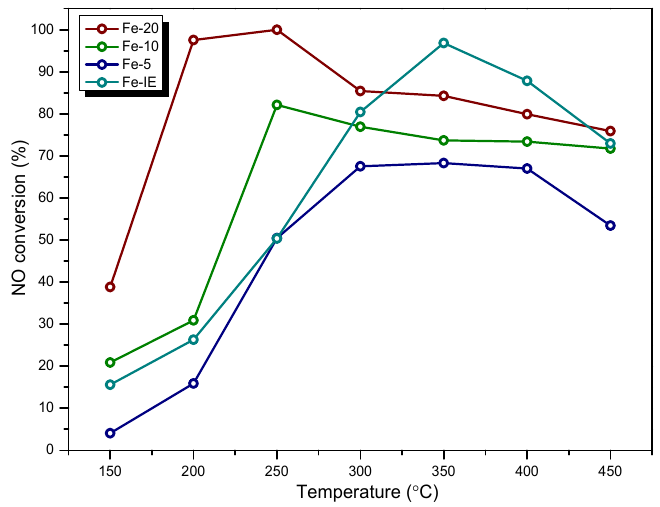
Figure 1. NO conversion obtained for the fresh catalysts.